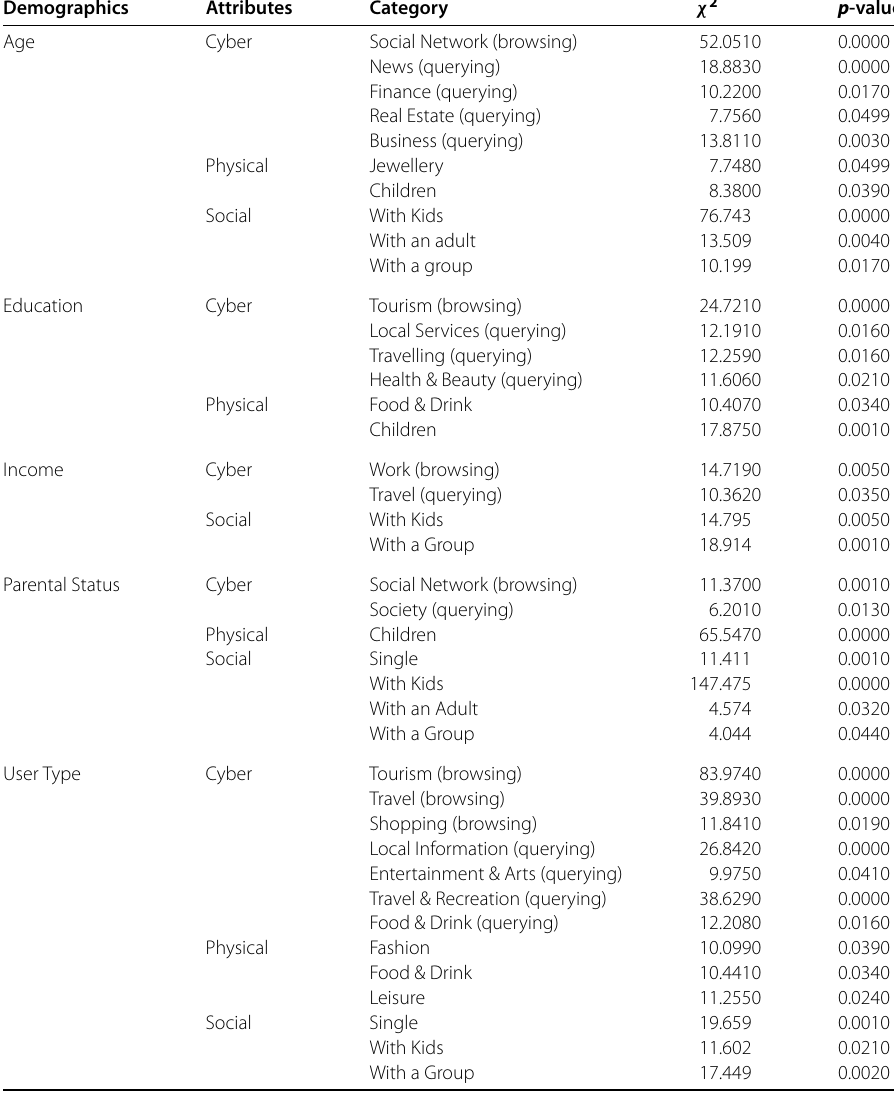
Table 6 The results of χ 2 test on category that shows significant difference among different user